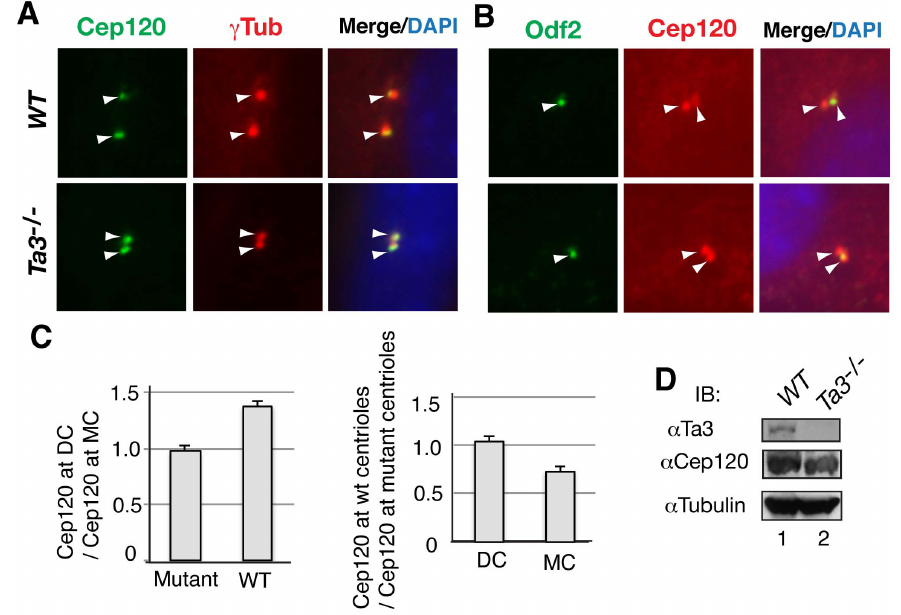
Figure 2. Ta3 is required for asymmetrical localization of Cep120 to the daughter centriole. Wild type and Ta3 mutant primary mouse embryonic fibroblasts (pMEFs) were coimmunostained for Cep120 and c ˜ tubulin (A) or Odf2 and Cep120 (B), together with DAPI (for nuclei). Arrowheads indicate the specific staining at centrioles. The Cep120 signal at the daughter and mother centrioles (DC and MC, respectively) was quantified for 21 randomly chosen cells, using NIH image J. Cep120 signal ratios were then calculated, specifically the DC to MC ratio and the wild type to Ta3 mutant ratio (average + standard deviation) (C). (D) No significant changes in Cep120 levels in Ta3 mutant MEFs. Immunoblots show the expression of endogenous Ta3 and Cep120 in wild type and Ta3 mutant MEFs, with tubulin as a loading control.